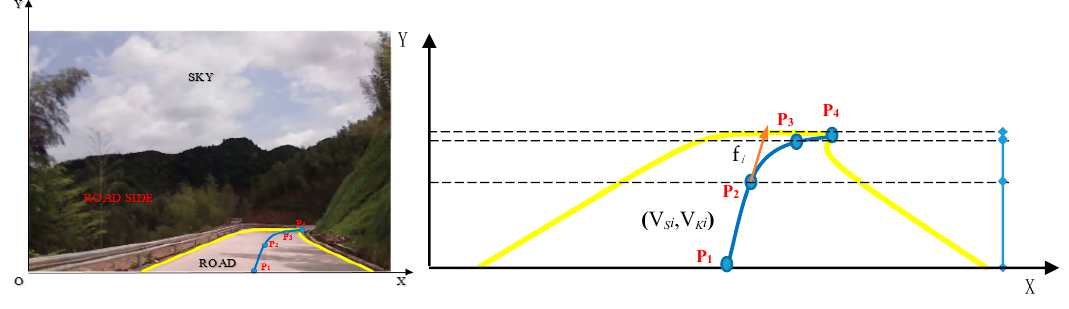
Figure 5. Driver-vision lane model based on driver’s visual perception (unit: pixel).